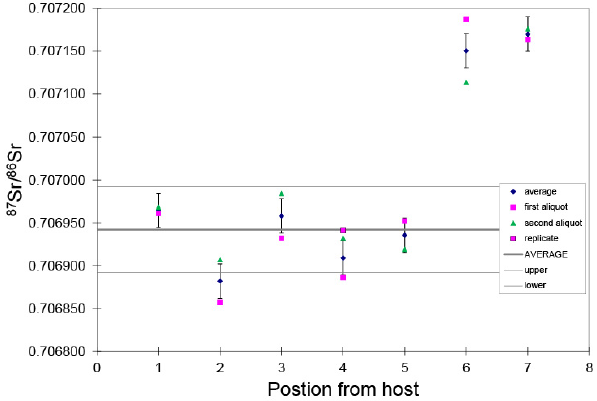
Figure 6. This graph shows Sr isotopes from the host to the center of the Neptunian dike. The aliquots were micro-sampled, dissolved and put through Sr spec resin, and run by thermal ionization mass spectrometry. The pink symbols represent two independent anal- yses from slabs that are at a quasi-equal distance from the host, and the blue diamond is the average of those analyses. While show- ing variability, the dark brown calcite has 87 Sr / 86 Sr like Capitanian seawater with an average of aliquots 1–5 of 0.706930 (0.000069). The samples from positions 6 and 7 are a light brown color, and a boundary is clearly visible in 6. These may represent later fluid alteration or an extended marine cement history. This is presented because we suggest that this sample may also be a useful Sr isotope reference material. The slabs are about 0.5cm